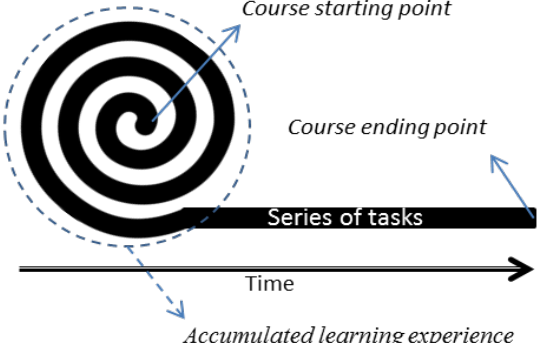
Figure 1 . Online learning experience - time and